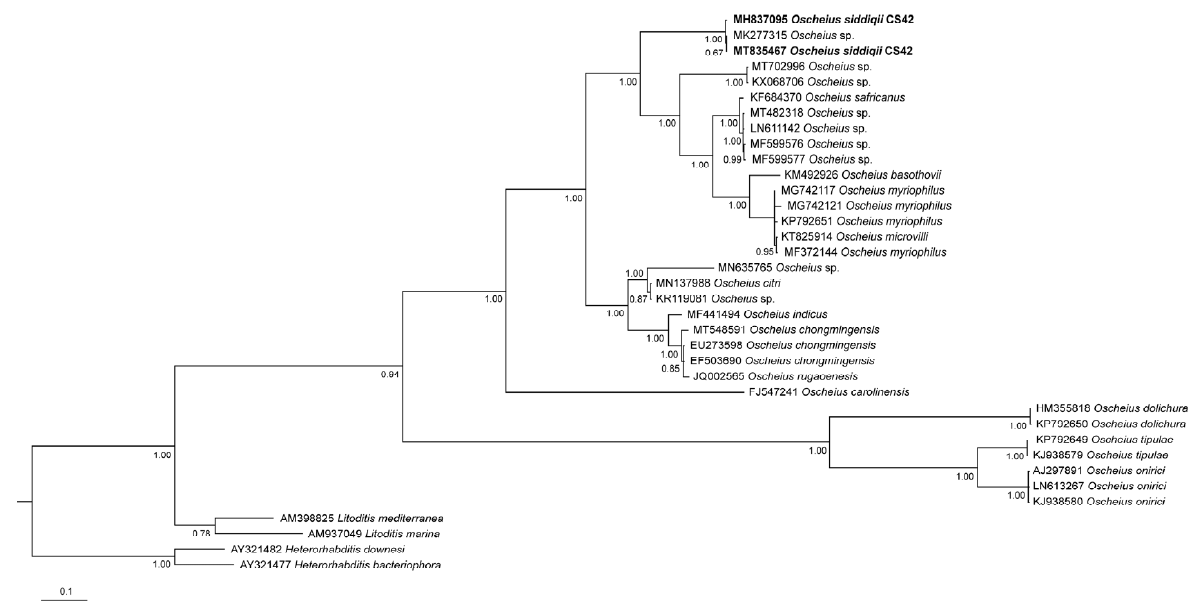
Figure 5. Phylogenetic relationships of Oscheius siddiqii and other Oscheius species as inferred from Bayesian analysis of sequences of the internal transcribed spacer (ITS1-5.8S-ITS2) rDNA segment. Bayesian posterior probabilities (%) higher or equal to 60% are provided at each node. The scale bar indicates the number of substitutions per site.